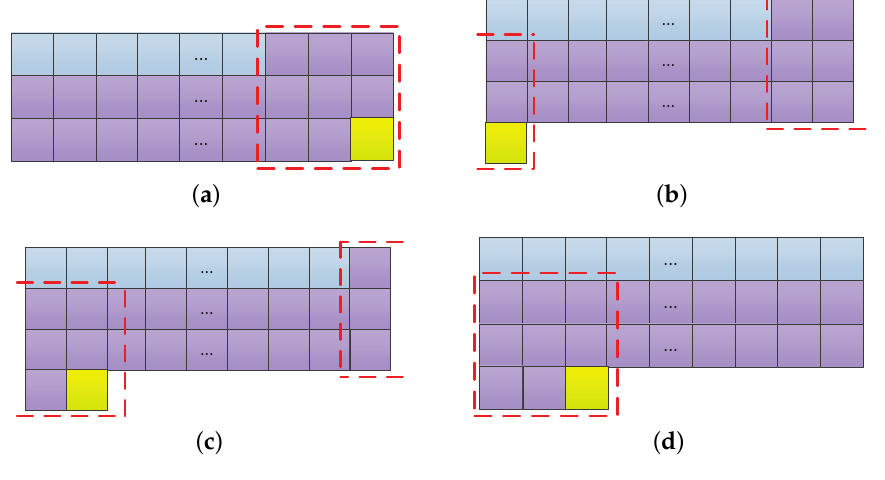
Figure 4. Sliding window strategy for recursive local summation RXD (R-LS-RXD): ( a ) No . ( Col − 2 ) window; ( b ) No . ( Col − 1 ) window; ( c ) No . Col window; ( d ) No . ( Col + 1 )